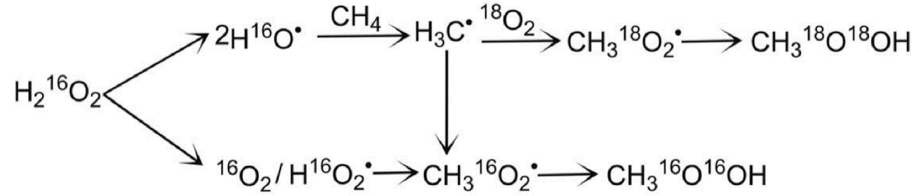
Figure 8. Proposed reaction scheme for CH 4 oxidation in the presence of H 2 O 2 and molecular O 2 . Reproduced with permission from [23]. Copyright 2017 American Association for the advancement of science.